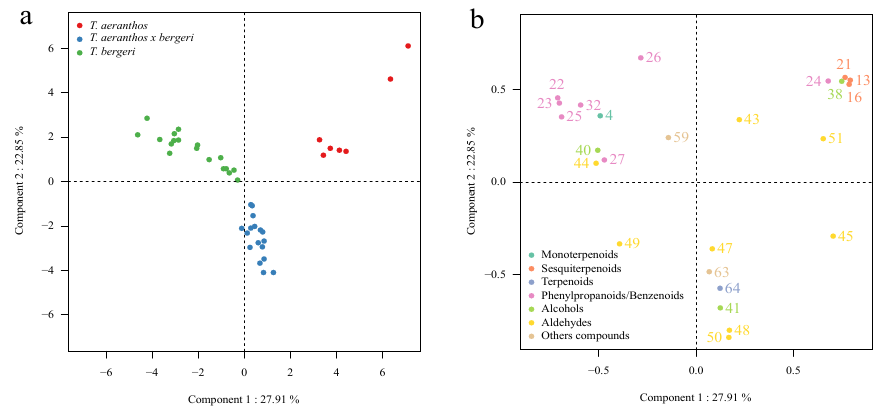
Figure 2. PCA based on VOCs emitted by T. aeranthos , T. bergeri, and T. aeranthos x T. bergeri (hybrids of the two species). ( a ) Score plot of PC1 scores versus PC2 scores. ( b ) Loading plot of PC1 and PC2 contributing volatile compounds. Numbers in ( b ) correspond to the compounds numbers listed in Table 2.